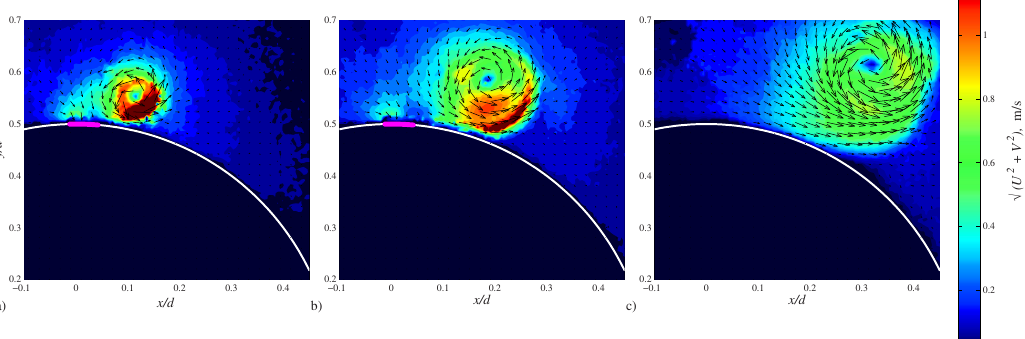
FIG. 2. (cid:1) Color online (cid:2) Development of starting vortex in still air. Plasma was activated for 33 ms at f plasma =25 kHz and E plasma = (cid:6) 3.5 kV. (cid:1) a (cid:2) t =8 ms; (cid:1) b (cid:2) Figure 3. Development of starting vortex in quiescent air for a DBD plasma activated for 33 ms with t =24 ms; (cid:1) c (cid:2) t =56 ms after the plasma was initiated. Plasma location is seen in frames (cid:1) a (cid:2) and (cid:1) b (cid:2) .